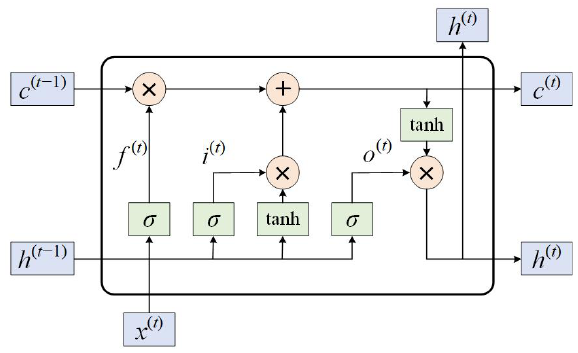
Figure 2. The basic structure of LSTM.